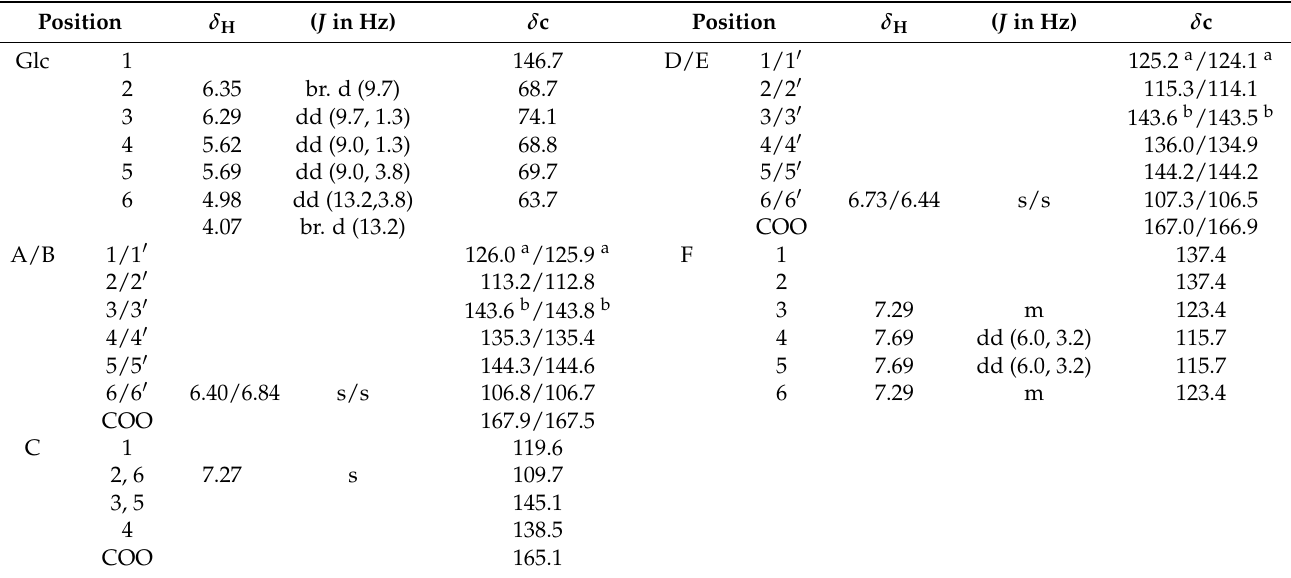
Table 2. 1 H (500 MHz) and 13 C (126 MHz) NMR data of 7 (in acetone- d 6